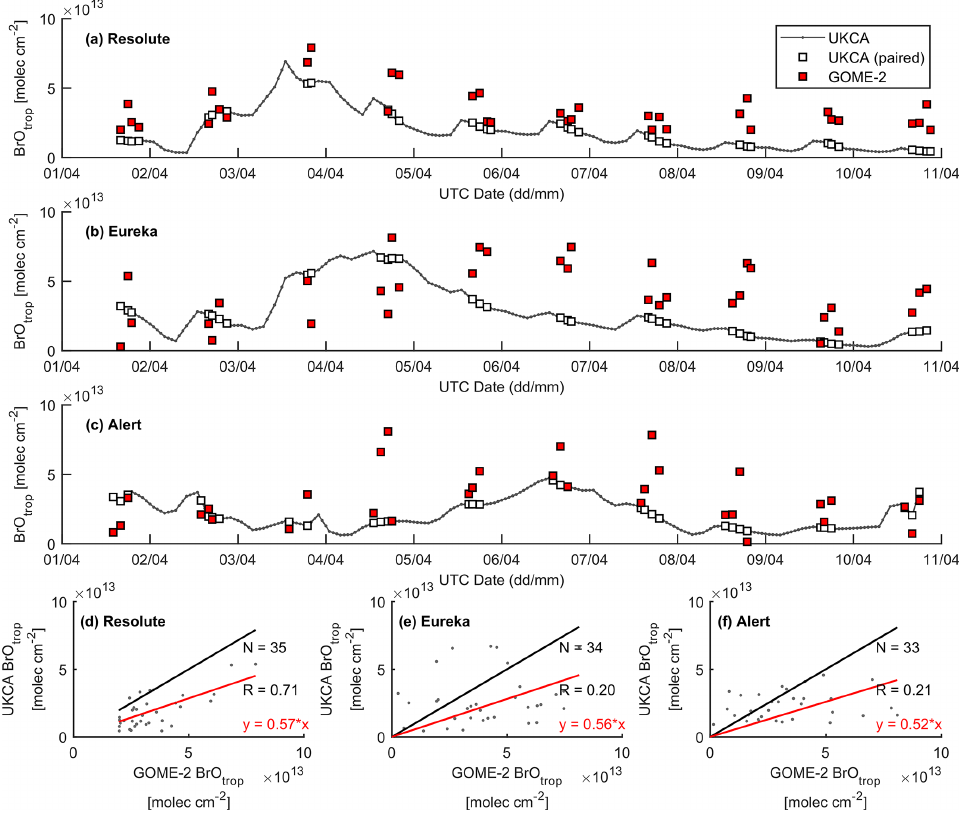
Figure 14. Time series of GOME-2 and UKCA_control tropospheric BrO column at (a) Resolute, (b) Eureka, and (c) Alert for the period 1–10 April 2011. Correlation plots between the model and GOME-2 are shown in (d) – (f) , with the black line representing a 1 : 1 plot and the red line representing the regression